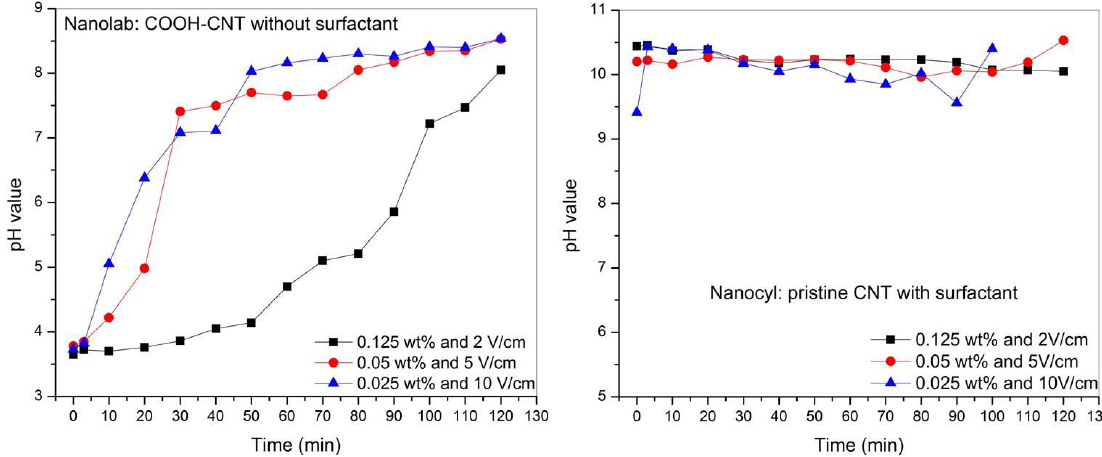
Figure 3. Evolution of pH value with time in the continuous EPD process for CNT suspension diluted from Nanolab product ( left ) and Nanocyl product ( right